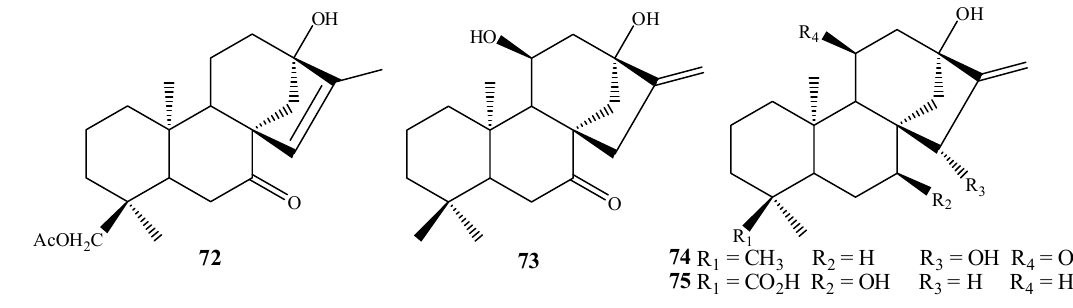
Figure 17. Products hydroxylated at positions C-11 and